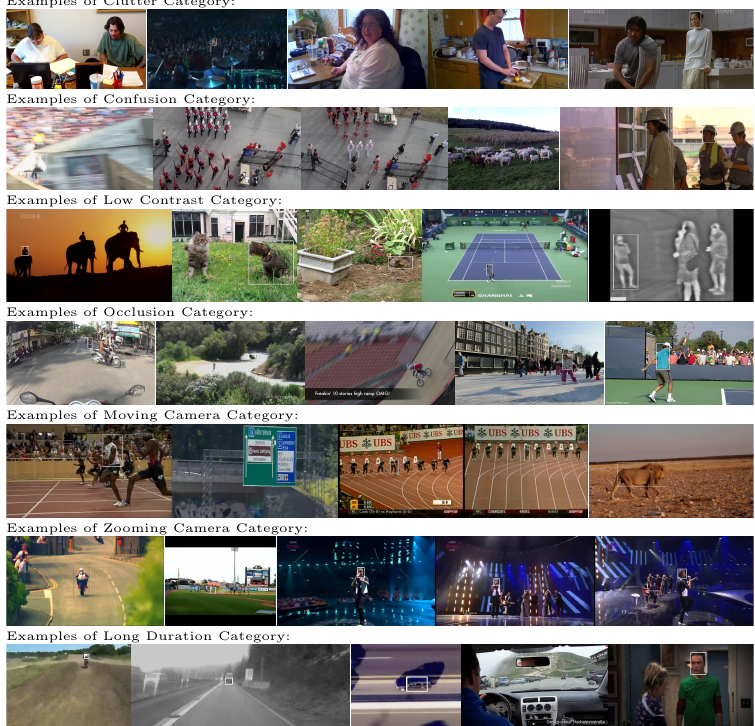
Figure 5. Example videos from the ALOV dataset (last seven categories). Only first frames are shown. The target object is